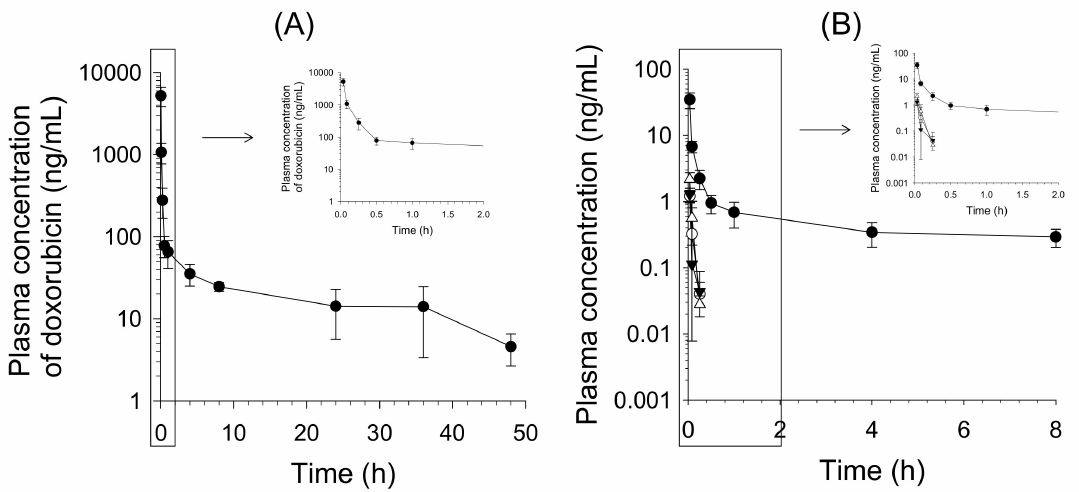
Figure 4. Mean plasma concentration–time profiles of ( A ) doxorubicin and ( B ) the four metabolites doxorubicinol ( ), doxorubicinone ( ), doxorubicinolone ( ), and 7-deoxydoxorubicinone ( ) after a single intravenous injection of doxorubicin at a dose of 1.3 mg/kg to female BALB/c nude mice. Points represent means ± SDs ( n = 5). The inset figures represent the plasma concentration–time curves of five analytes from 0 h to 2 h.